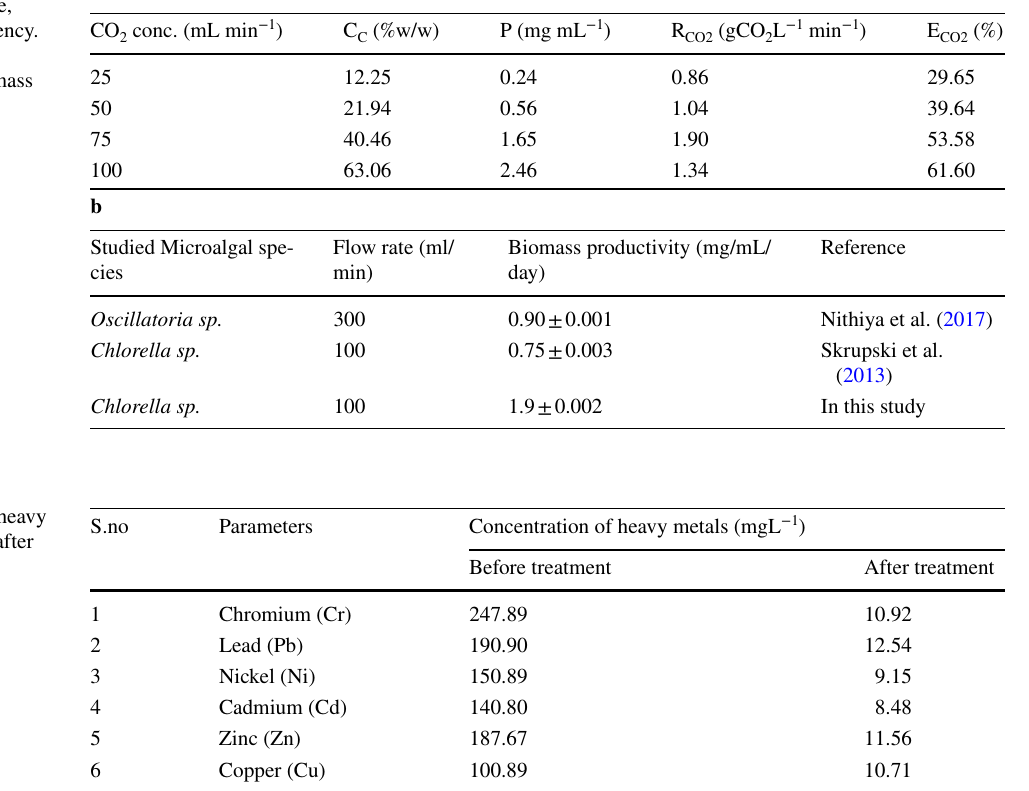
average CO 2 utilization rate, and CO 2 biosorption efficiency. b Comparison different microalgal species for biomass productivity at pure CO 2